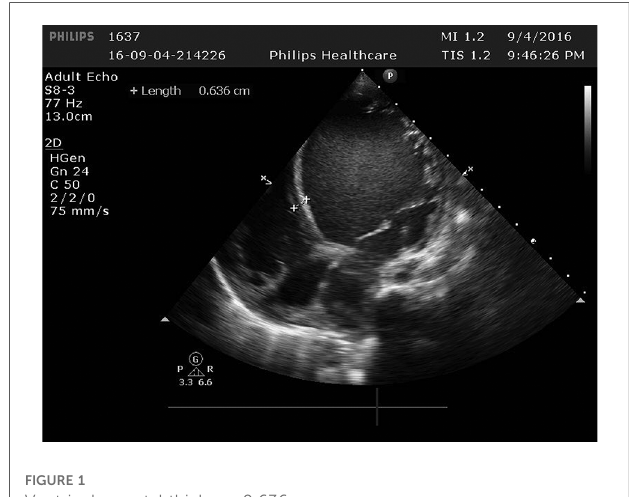
FIGURE 1 Ventricular septal thickness0.636 cm.